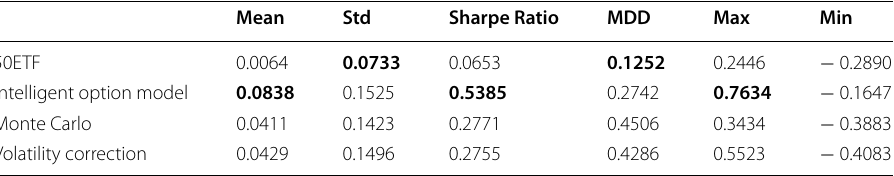
This table shows the results of the option portfolio model under different forward price predictive methods. The portfolio is held to maturity and the adjustment frequency is monthly